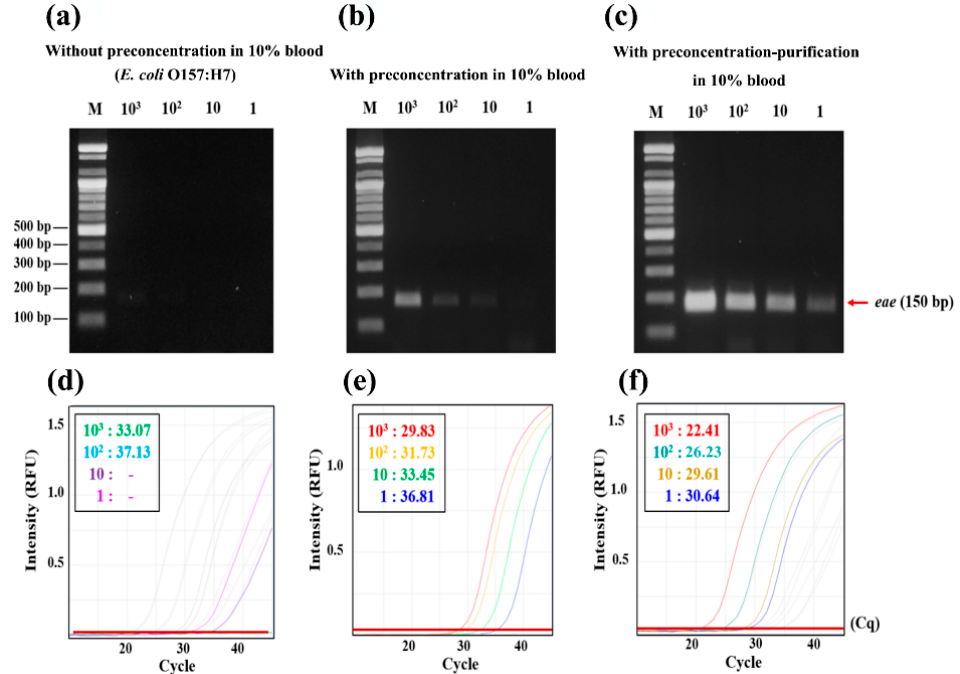
Figure 7. Confirmation of preconcentrating and DNA purification efficiency of E. coli O157:H7 in 10% blood using PCR with post gel electrophoresis after PCR ( a – c ) and qPCR ( d – f ). ( a ) Gel electrophoresis of PCR products ( eae gene) from 10 mL of 10% blood containing E. coli O157:H7 at different concentrations (1–10 3 CFU/mL) without preconcentration; ( b ) after preconcentrating; ( c ) after preconcentrating and DNA purification; ( d – f ) qPCR results of ( a – c ), respectively.